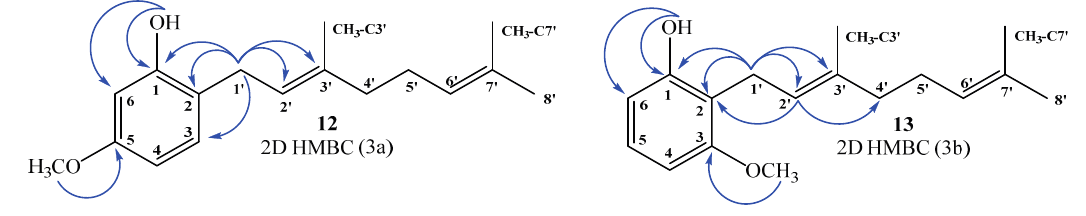
Figure 3. Most important correlations 2D 1 H– 13 C HMBC, compound 12 ( 3a ) and compound 13 ( 3b ).